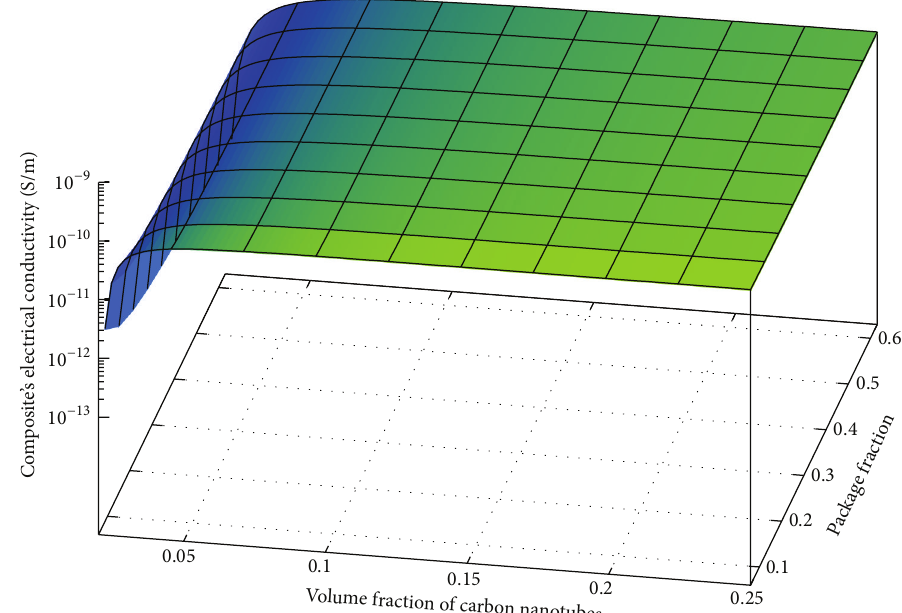
Figure 21: DC electrical conductivity of the nanocomposite at varying both the packaging fraction of the filler and the volume fraction of the filler (Mamunya’s